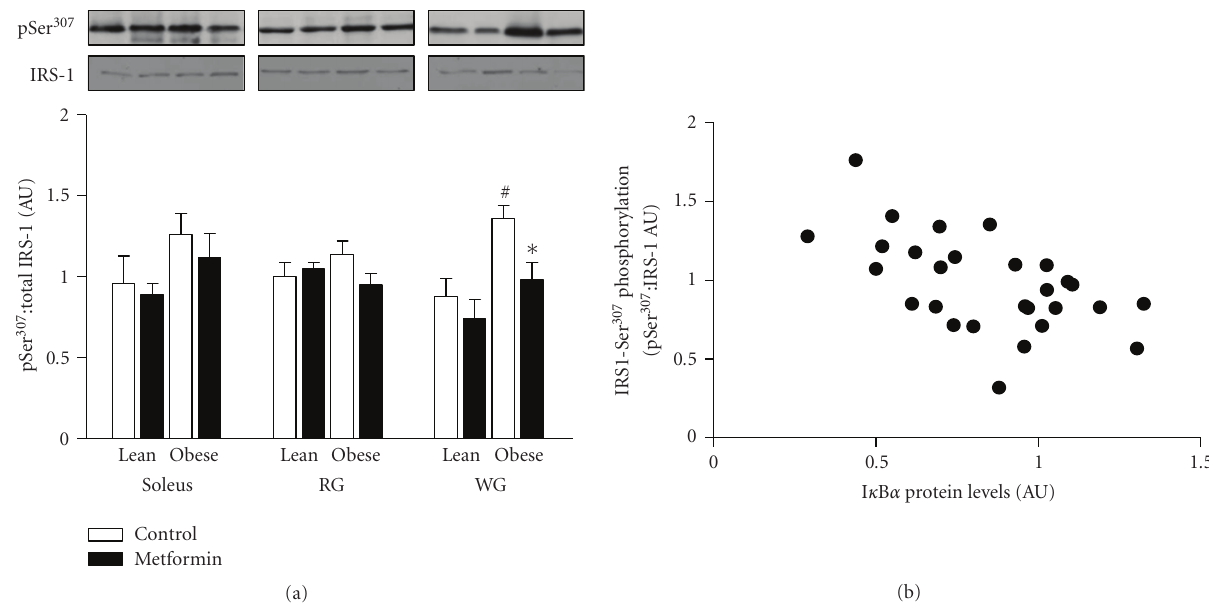
Figure 3: The e ff ect of vehicle (open bars) or metformin (filled bars) on IRS1-pSer 307 in soleus, RG, and WG (a) and the correlation between I κ B α and IRS1-pSer 307 (b) in WG from obese and lean Zucker male rats. P < . 05 for vehicle versus metformin treatment within same phenotype ( ∗ ) and lean versus obese within a given treatment (#). I κ B α and IRS1-pSer 307 levels were significantly related in WG ( r = − 0 . 789, P < .